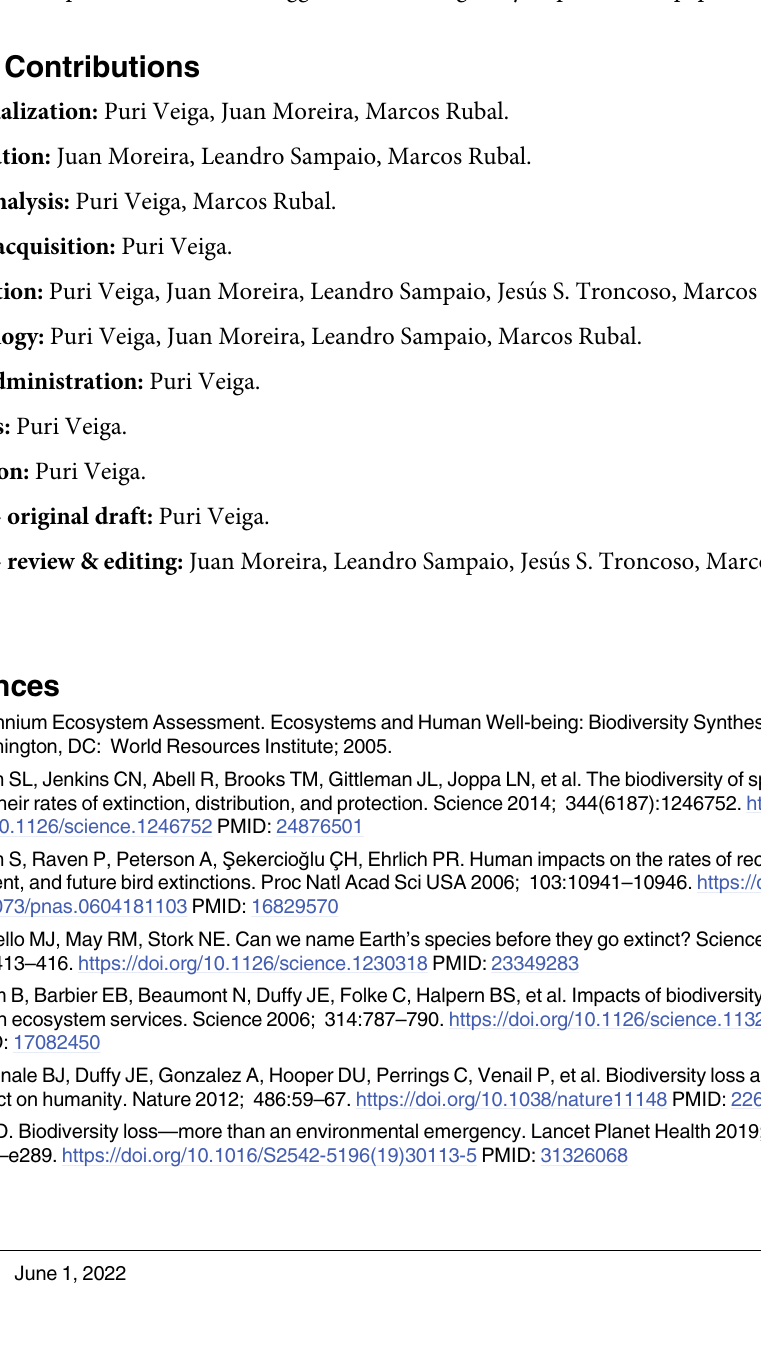
S1 Table. Results of SIMPER analysis. Contribution ( δ i) of individual taxa to the average Bray-Curtis dissimilarity between treatments at the studied sites that showed significant differ- ences in epifaunal assemblage structure. S2 Table. Full